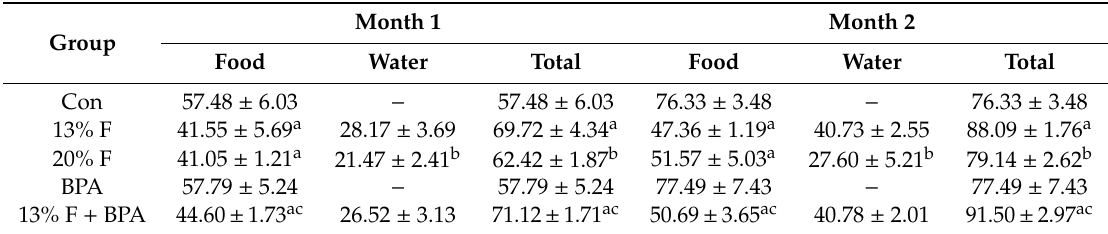
Values are expressed as means ± SD, n = 10. Differences between groups were considered as significant at p < 0.05 and were analyzed with one-way ANOVA. a different compared to Con; b different compared to 13% F; c different compared to BPA ( p < 0.05). Con, control group; F, fructose group; BPA, 1 µg/mL BPA group.